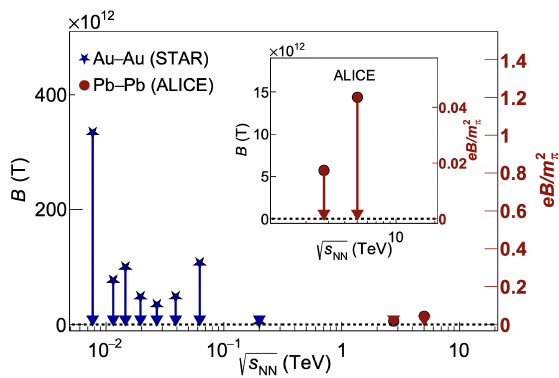
Figure 2: The upper limit of the magnetic field at freeze-out relative to collision energies determined from the global Λ and ¯ Λ hyperon polarisation measured at the LHC and RHIC [20, 21]. This figure is adopted from